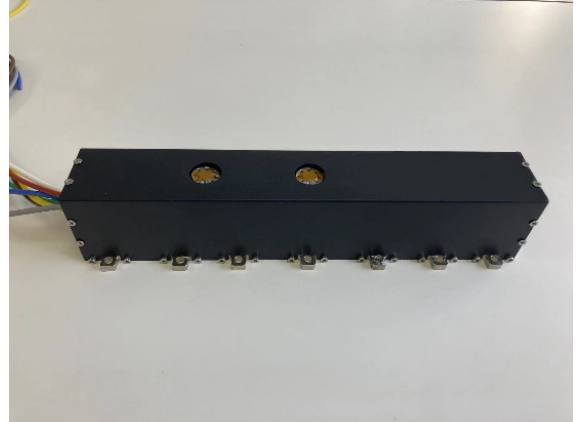
Figure 21. The photo of the packaged G-band TWT.